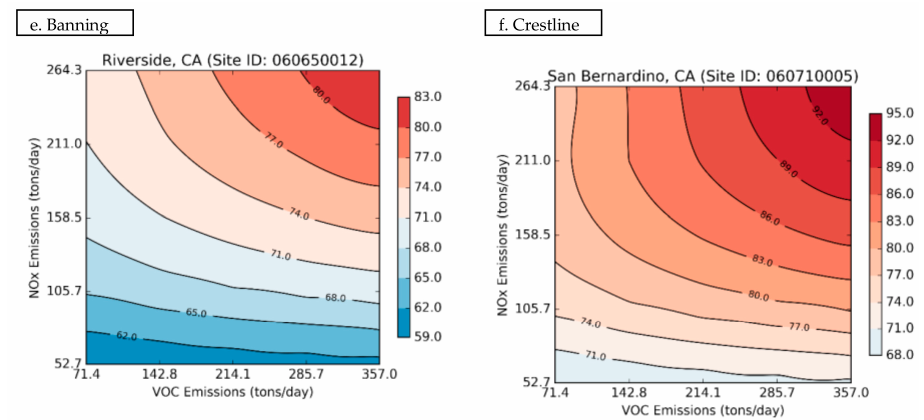
Figure 2. Future-year ozone design value isopleths (ppb) for monitors in the South Coast Air Basin (SoCAB): ( a ) Glendora, ( b ) Los Angeles-North Main, ( c ) Pasadena, ( d ) Anaheim, ( e ) Banning, and ( f ) Crestline.